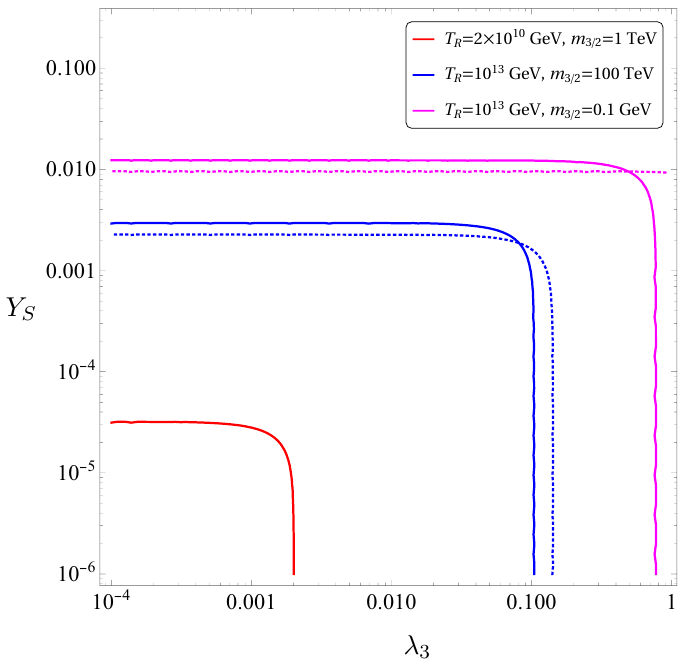
Figure 6 . The allowed regions in the plane ( λ 3 , Y S ) , corresponding to constraints on reheating